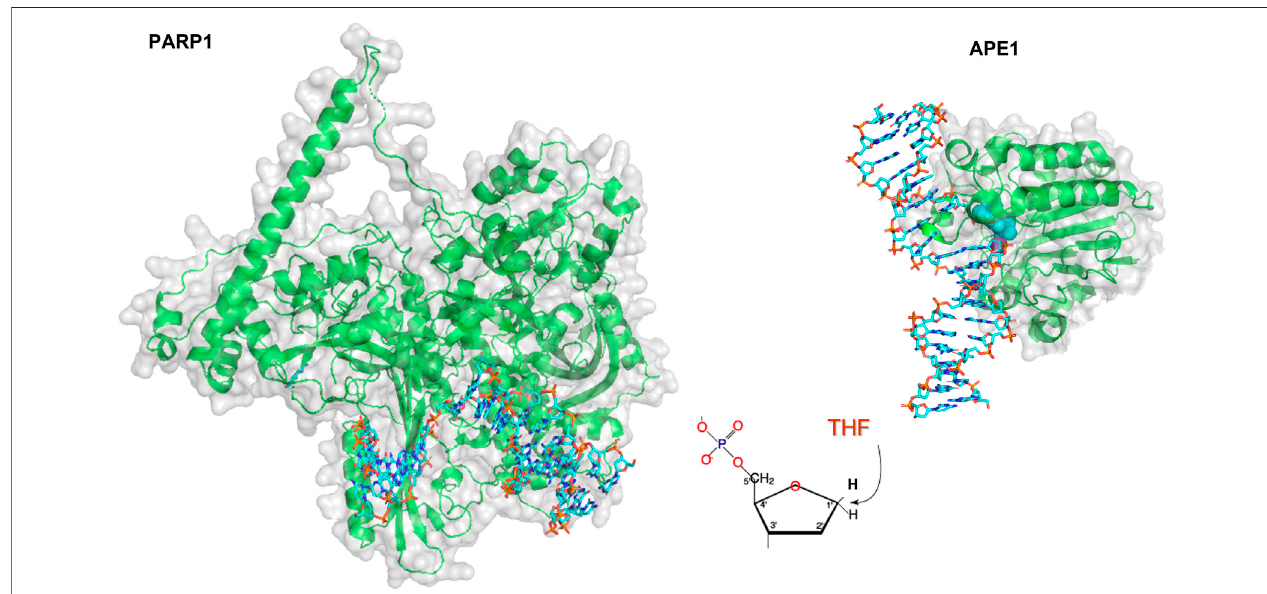
FIGURE 9 | Models of PARP1 and APE1 bound to DNA repair intermediates. (Left) PARP1 (green cartoon) bound to DNA (cyan sticks) containing a single strand break. Structure was created using Alpha-fold generated structure (Jumper et al., 2021) and docking in the DNA from a co-crystal structure of Pol β bound to a nicked DNA substrate (PDB ID: 4KLO) using HDOCK (Yan et al., 2020). (Right) Crystal structure of APE1 (green cartoon) bound to DNA (cyan sticks) containing an abasic site analog, THF. APE1 taken from PDB code